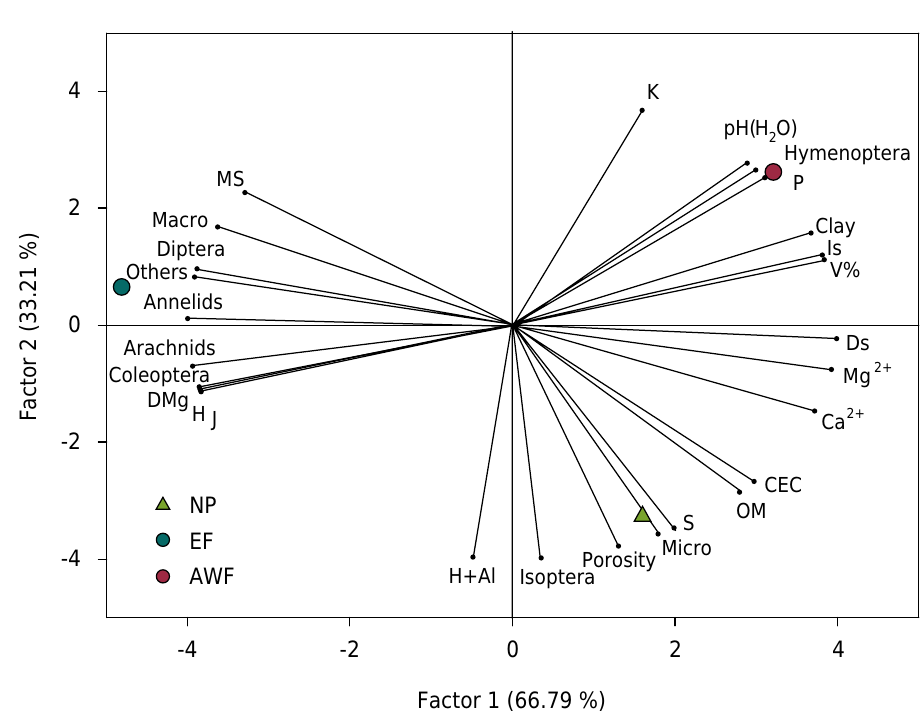
Figure 4. Principal Component Analysis (PCA) between the natural pasture (NP), the eucalyptus forest (EF), and the eucalyptus forest after wildfire (AWF), and the soil physical, chemical, and biological properties in São Gabriel, RS, Brazil. Is = Simpson index; H = Shannon index; J = Pielou index; Macro = macropososity; Micro = microporosity; Porosity = total porosity; Ds = soil bulk density; OM = organic matter content; V% = base saturation; H+Al = potential